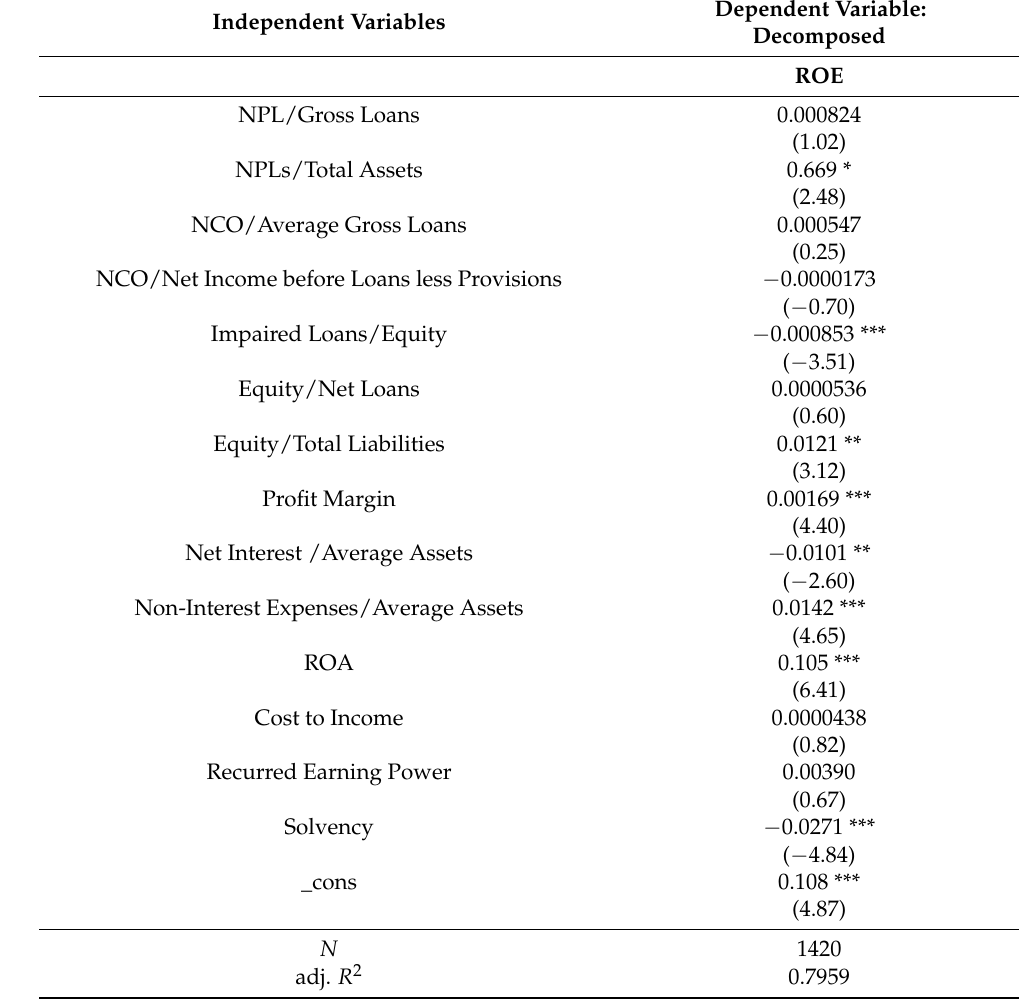
Table A11. Panel regression (with random effects and robust standard errors) with decomposed ROE (measured as addressed by ECB (2010)) as the dependent variable and ratios describing the major characteristics of the banks as independent variables (directly extracted from ORBIS). The complete sample is made up of 142 Italian banks and the timespan is from 2011 to 2020.